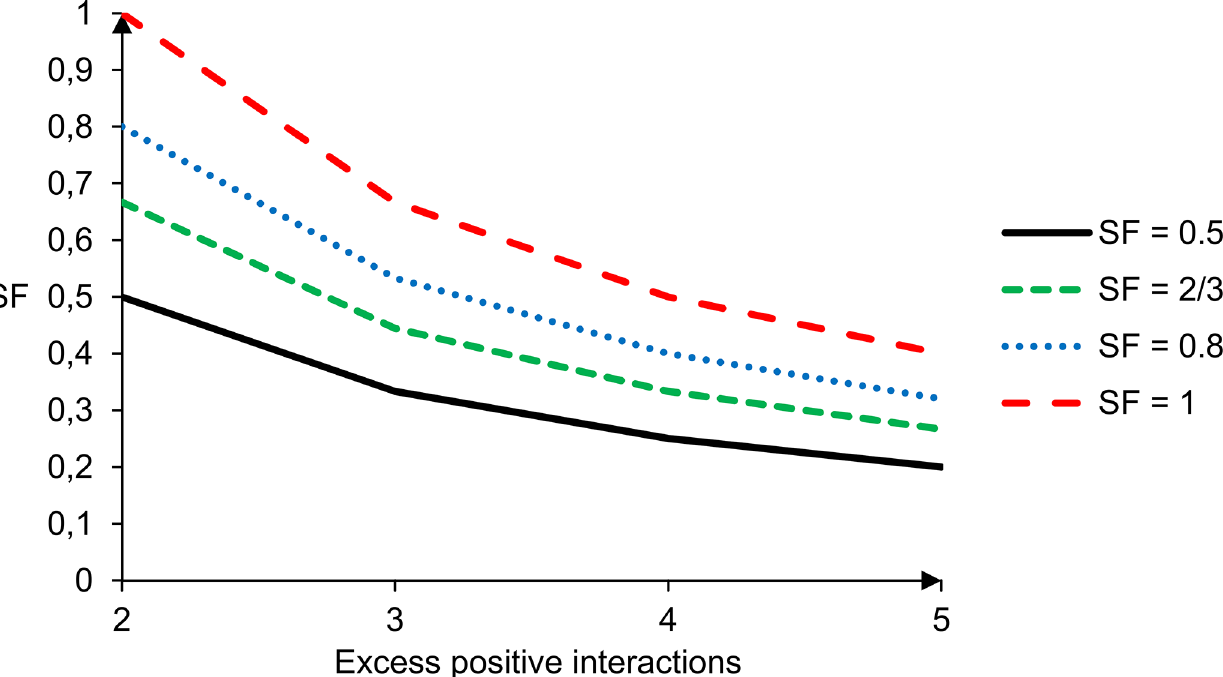
Fig 4. Weights for various values of the saturation factor. The value of the horizontal axis shows the number of excess positive interactions. E.g. 5 corresponds to the case where 5 positive interactions are present (or 6 positive interactions and 1 inhibition etc). When SF = 0,5 there is no saturation. For example, all 5 positive interactions must be fully active to achieve the maximal activity of 1. Alternatively, the plot can be regarded as the activity a node will take when only one upstream node, out of 2, 3, 4 and 5 nodes respectively, is active. The higher the saturation factor, the higher this value will